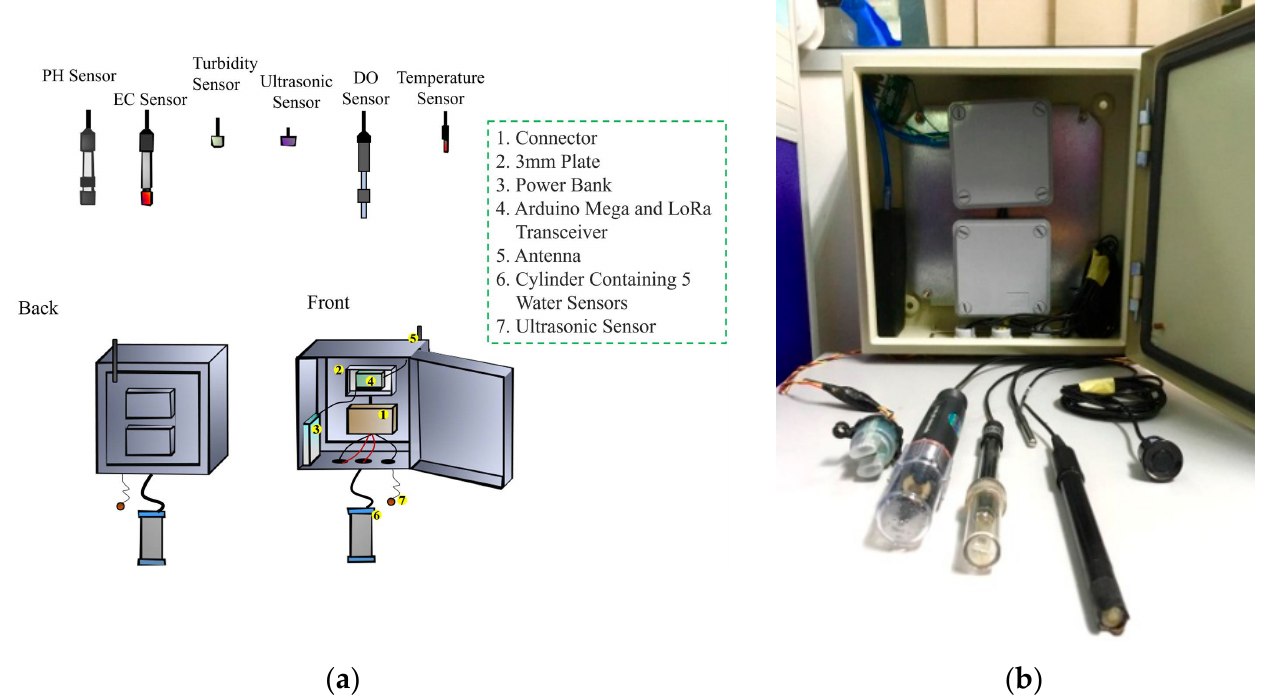
Figure 3. ( a ) Water node cabinet technical layout and ( b ) the integrated water quality monitoring system.